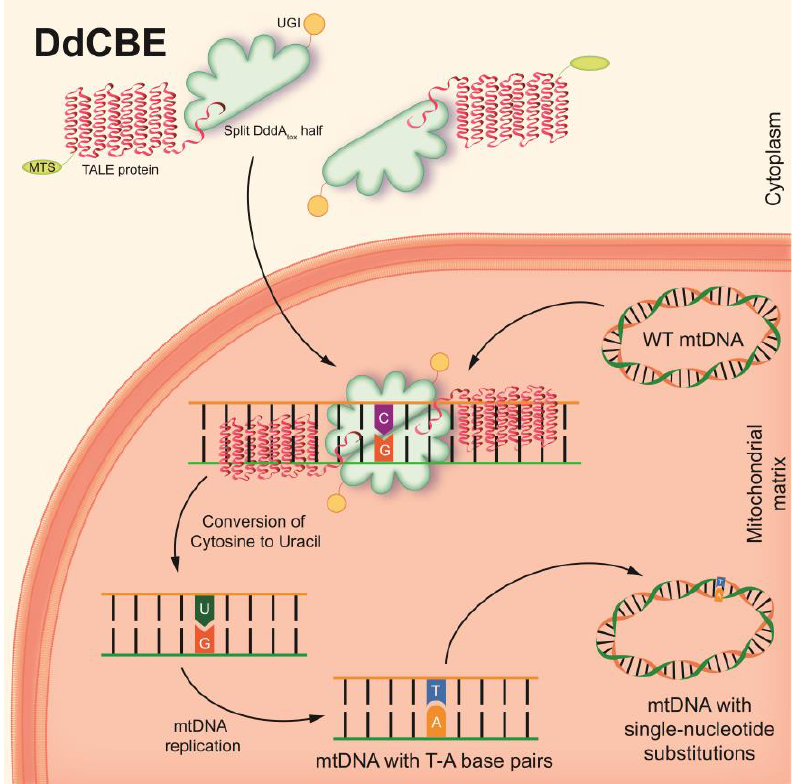
Figure 3. The basic principle of DdCBEs. The two inactive halves of the DdCBE construct import into the mitochondria. After assembly on the target site of the mtDNA by adjacently bound programmable TALE arrays, DdCBE converts cytosine to uracil. UGI protects uracil from the glycosylase until the occurrence of the next round of mtDNA replication. mtDNA replication results in the replacement of uracil by thymine and guanine from the complementary strand by adenine. Thus, DdCBEs catalyze C(G)-to-T(A) conversions in mtDNA without DSB formation with high specificity.